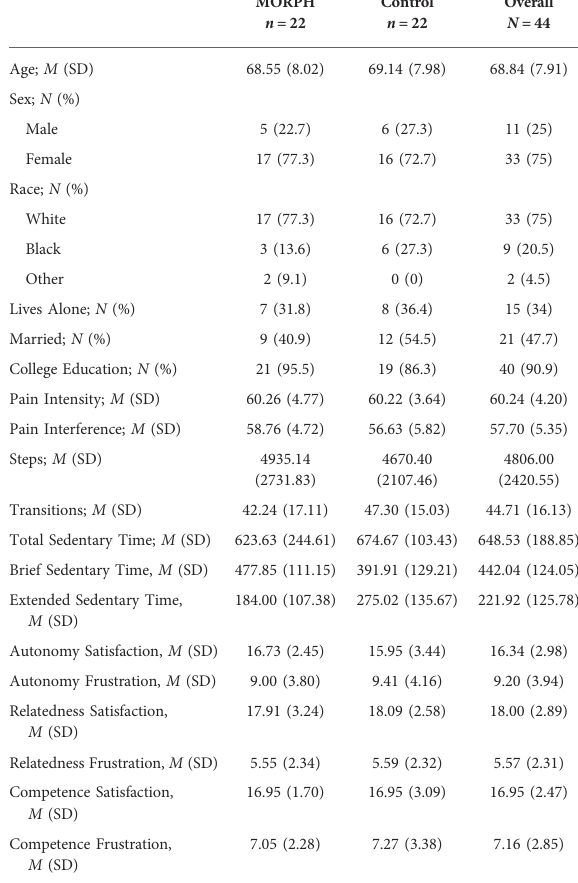
TABLE 1 Participant characteristics, pain, activity behaviors, self- determination theory measures at baseline. M , mean, SD, standard